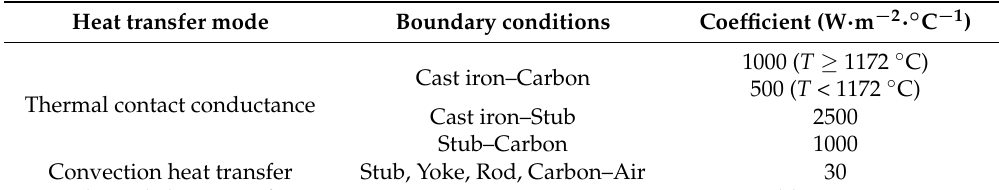
Table 3. Boundary conditions summary.